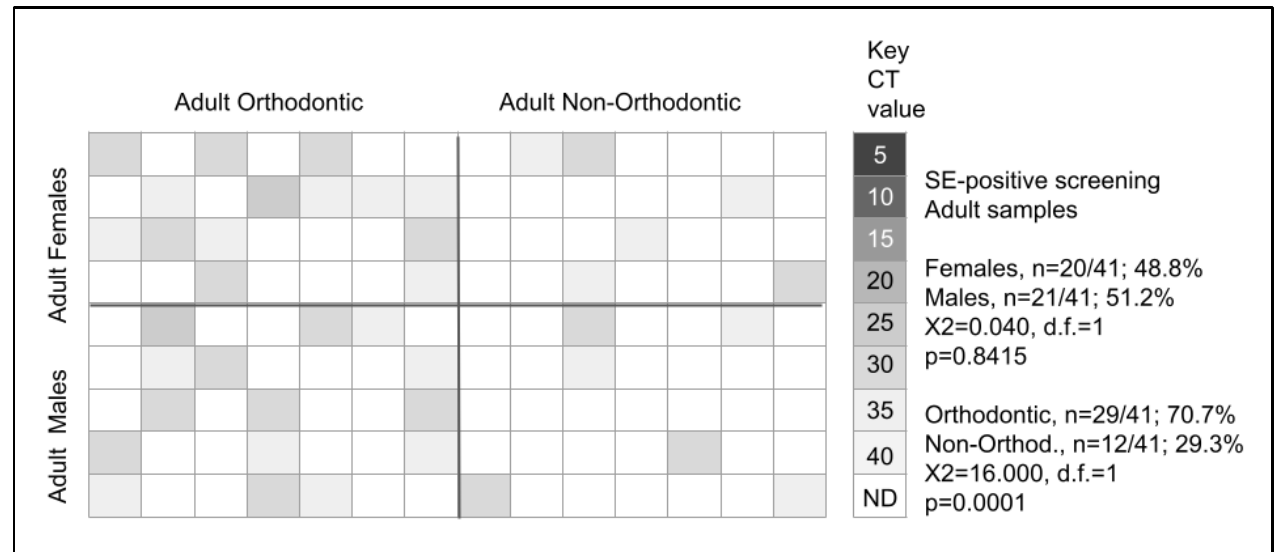
6 of 11 Figure 1. qPCR screening of pediatric samples for Slackia exigua (SE). Screening revealed n = 70/141 (49.6%) harbored Slackia exigua (SE), which was nearly equally divided among females (45.7%) and males (54.3%), p = 0.4237. The majority of Slackia exigua ( SE)-positive samples were found among orthodontic patients (71.4%) versus non-orthodontic samples (28.6%), p = 0.0001. Adult samples were also screened for the presence of Slackia exigua or SE (Figure 2). These data revealed that n = 41/125 or 32.8% of samples harbored Slackia exigua (SE). More detailed analysis of these data revealed that 20/41 or 48.7% of the Slackia exigua (SE)-posi- tive samples were derived from adult females, with the remainder 21/41 or 51.3% from adult males, which was not statistically significant, p = 0.8415. However, analysis of these data by orthodontic status revealed that n = 29/41 or 70.7% of the Slackia exigua (SE)-posi- tive samples were found among adult orthodontic patients with only n = 12/41 or 29.3% from adult non-orthodontic samples, which was statistically significant, p = 0.0001. More detailed analysis of adult female orthodontic patients revealed n = 14/30 or